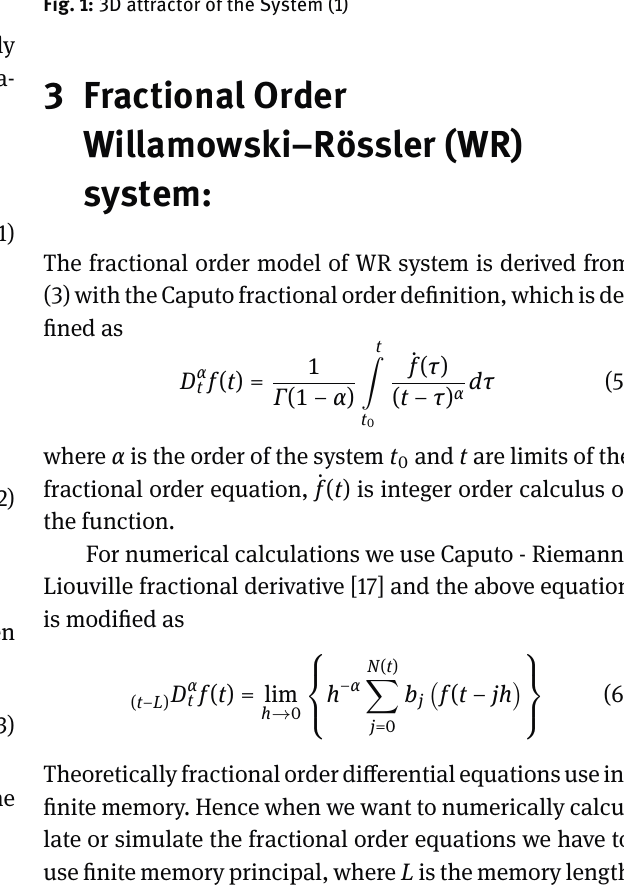
Fig. 1: 3D attractor of the System